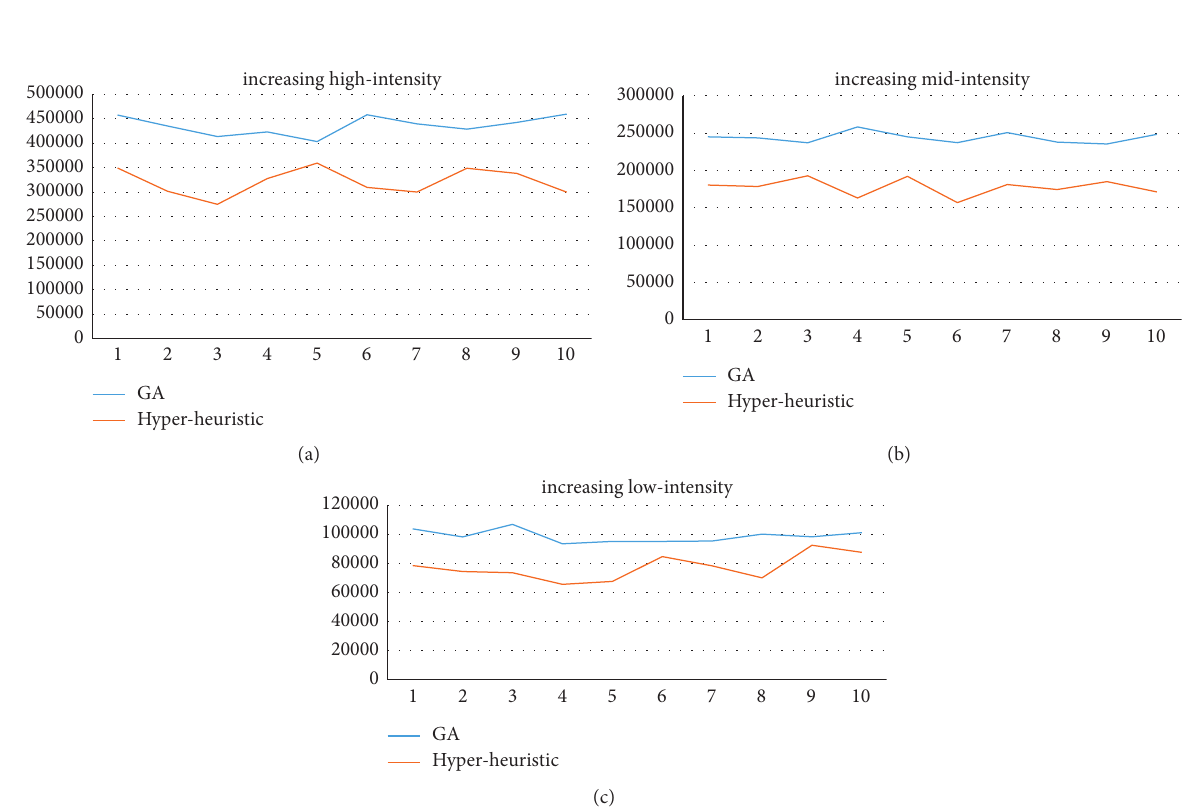
Figure 8: Result curve of GA and hyperheuristic algorithm of increasing passenger flow. (a) High-intensity passenger flow. (b) Medium- intensity passenger flow. (c) Low-intensity passenger flow.